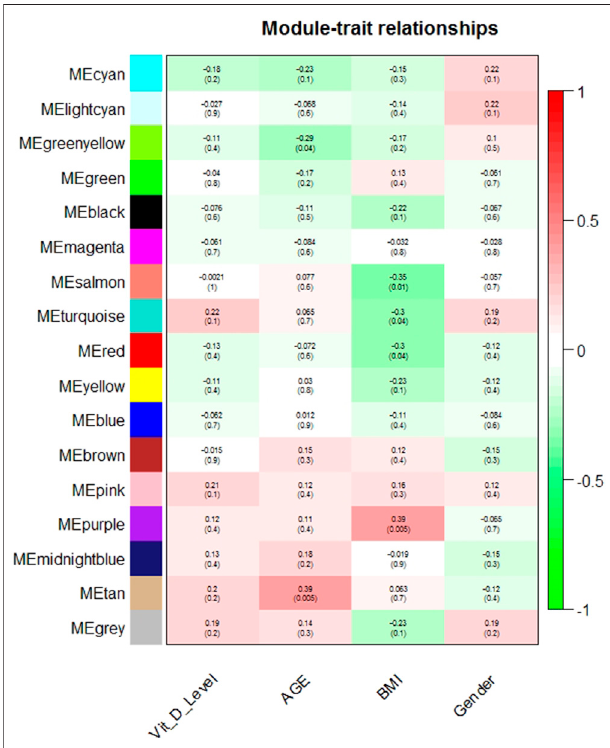
FIGURE 1 | Module-trait relationships in the post-vitamin D network. Pearsoncorrelation ofmodule eigenvector ( fi rst principal component)and trait (along with nominal p